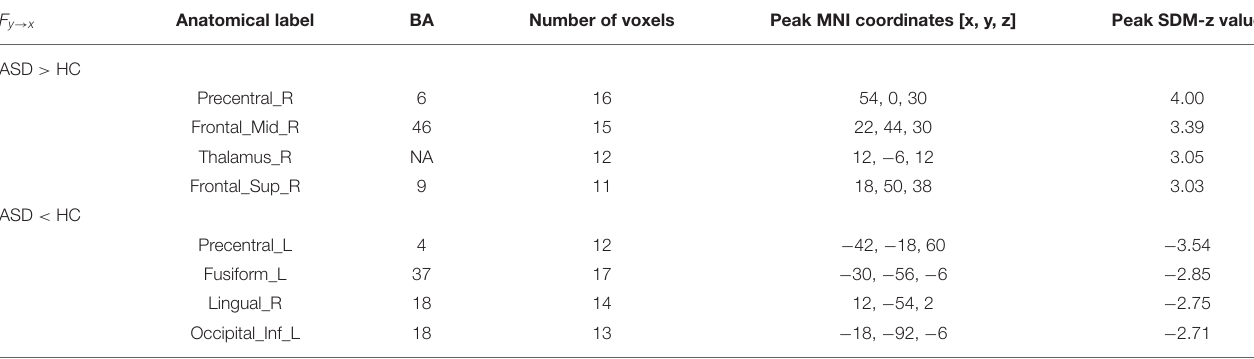
TABLE 3 | The GCA results from the whole brain to seed. F y → x Anatomical